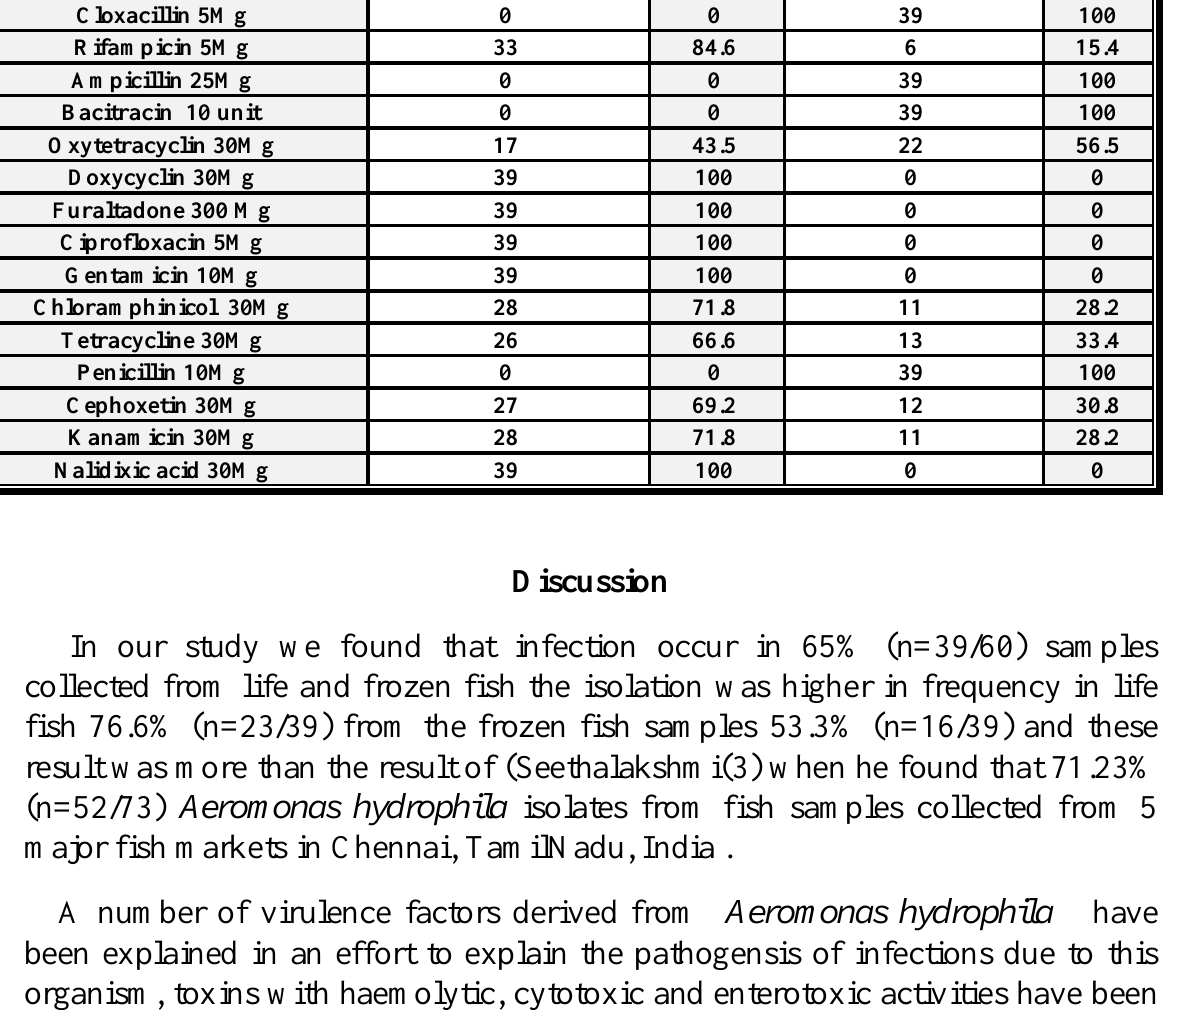
Table 3: shows the results of antibacterial sensetivity test Drugs No. of sensetive % No. of resistant % Streptomycin 10